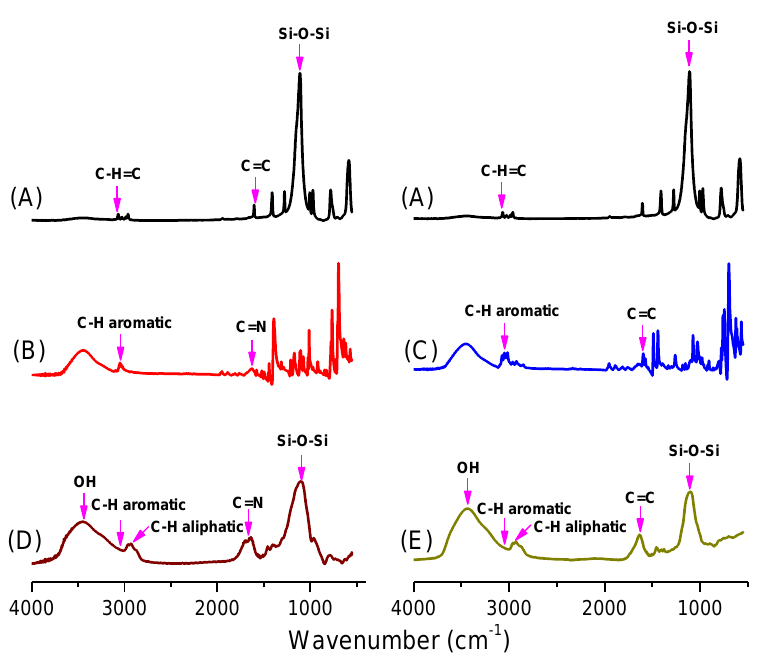
Figure 2. Fourier-transform infrared spectroscopy (FTIR) spectra of ( A ) octavinylsilsequioxane (OVS), ( B ) TPP, ( C ) TPE, ( D ) POSS-TPP, and ( E ) POSS-TPE.